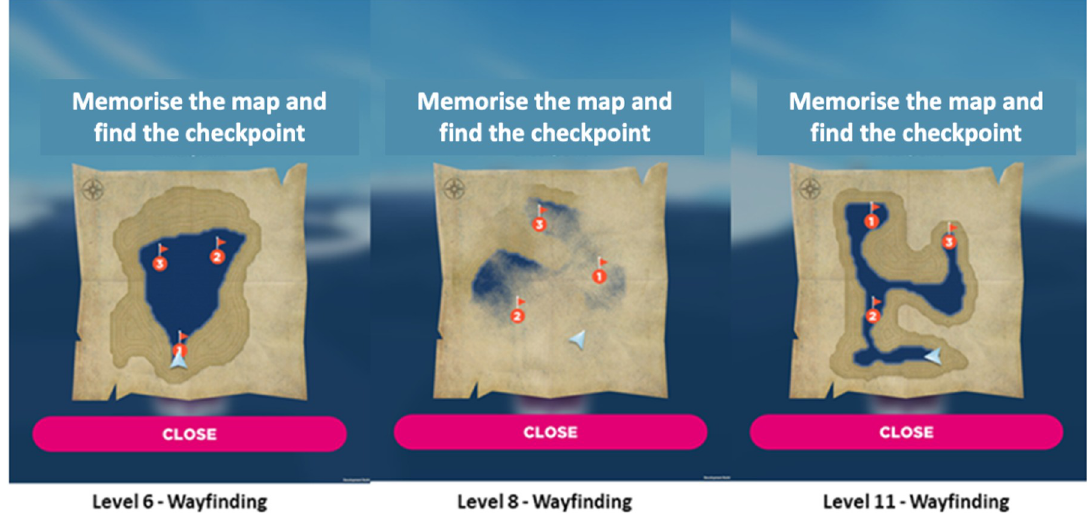
Fig 2. SHQ goal-orientated wayfinding levels (A) 6, (B) 8 and (C). Players initially see a map featuring a start location and several checkpoints (in red) to find in a set order. Checkpoints are buoys with flags marking the checkpoint number. Participants study a map of the level for a recorded number of seconds. When participants exit the map view, they are asked to immediately find the checkpoints (or goals) in the order indicated on the map under timed conditions. As participants navigate the boat through the level, they must keep track of their location using self-motion and environmental landscape cues such as water-land separation. The initiation time is zero as the boat accelerates immediately after the map disappears. If the participant takes more than a set time, an arrow appears pointing in the direction along the Euclidean line to the goal to aid navigation. Adapted from Coughlan et al.